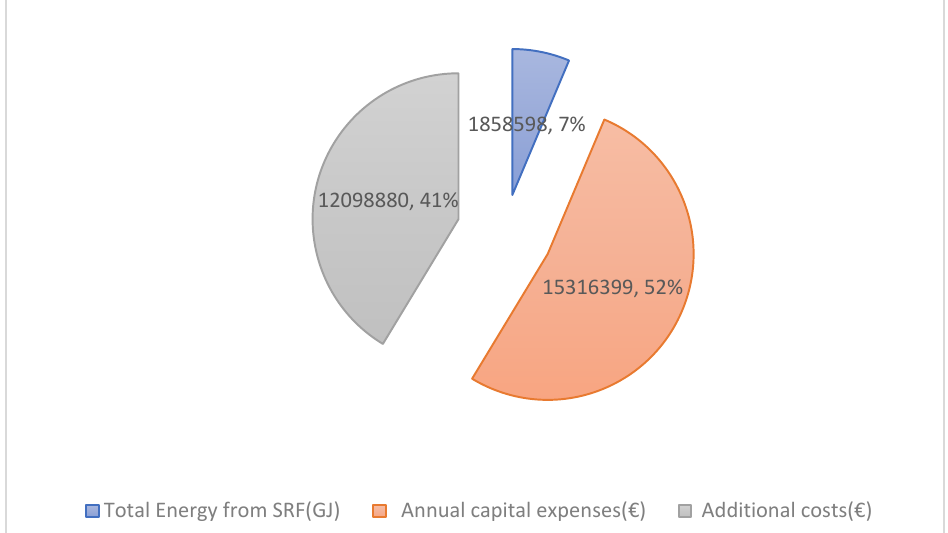
Figure 5. Energy and cost saving analyses.